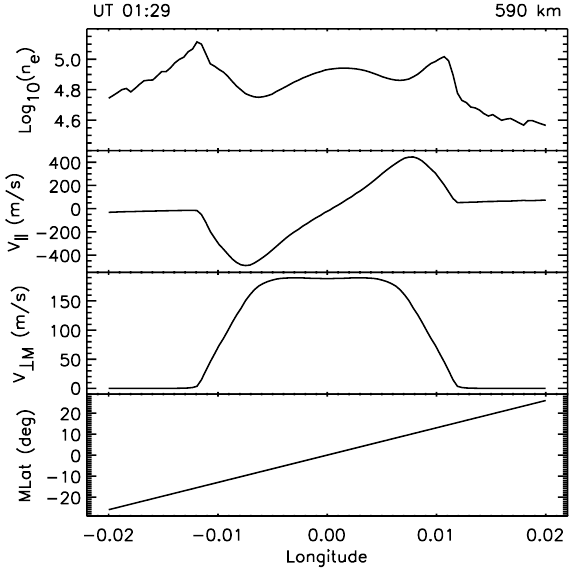
Fig. 7. Plots of log 10 n e , field-aligned O + velocity ( V k , positive = northward), vertical E × B velocity ( V ⊥ M ), and magnetic latitude versus longitude along a trajectory fixed altitude